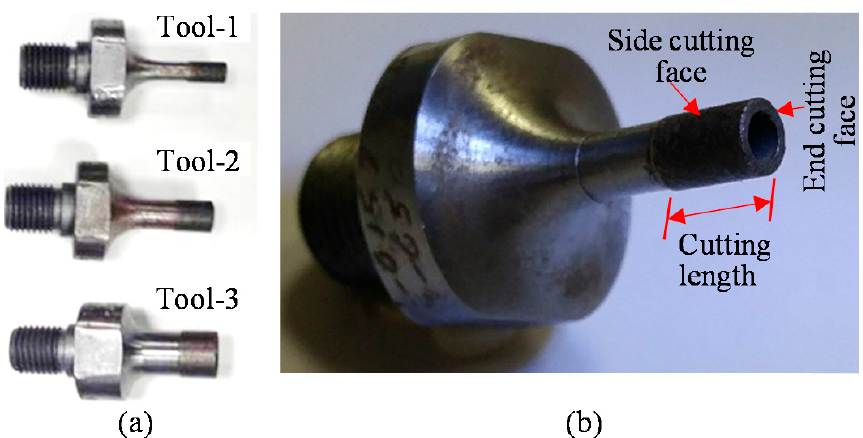
Figure 3. ( a ) Three different diameters of metal bonded diamond drills used in experiments; ( b ) Zoomed-in view of a metal bonded drill.